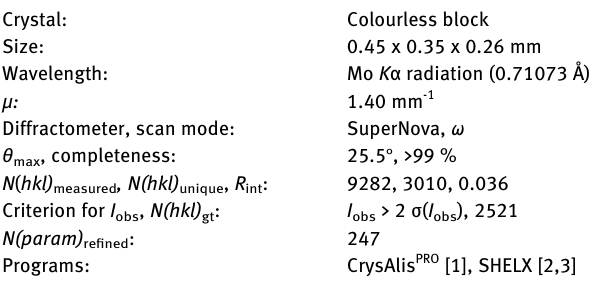
Table  : Data collection and